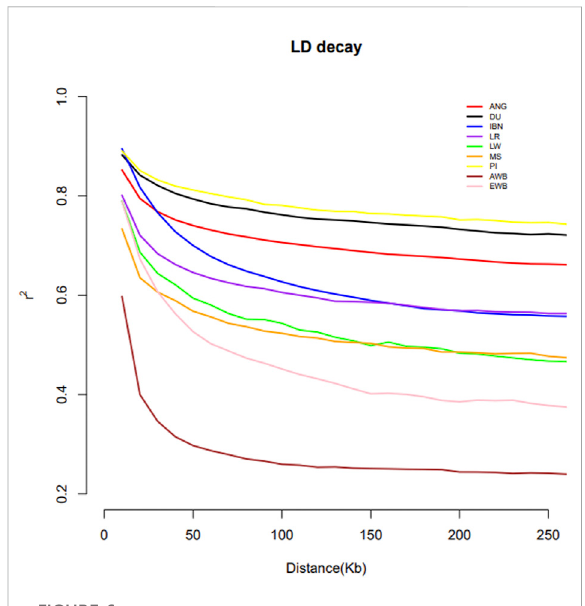
FIGURE 6 Linkage disequilibrium pattern of ANG pigs, European and Asiapigbreedsandoftheirwildcounterparts.Bailundopigs(ANG), Asian wild boar (AWB) and Meishan samples (MS), European wild boar (EWB) and European domestic, including Large White (LW), Duroc (DU), Landrace (LR), Pietrain (PI) and Iberian (IBN)